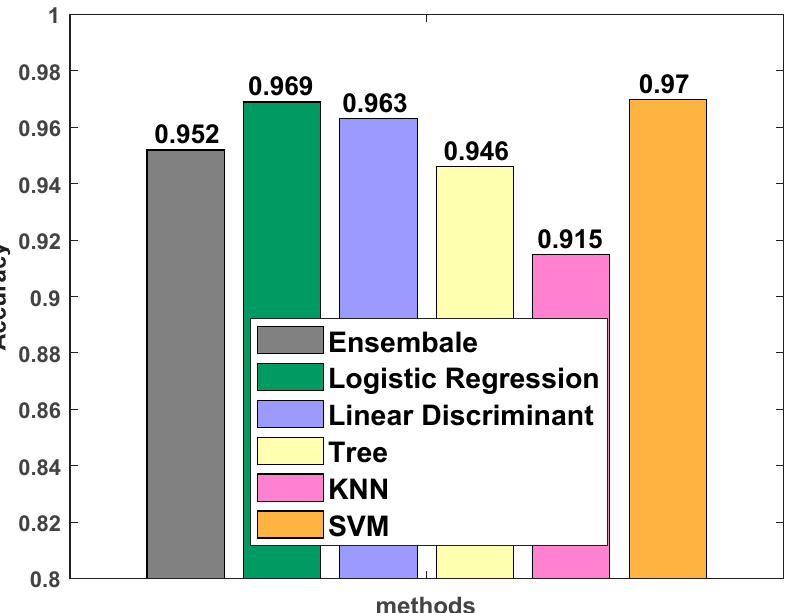
Figure 9. Precision comparison for the classification algorithm.